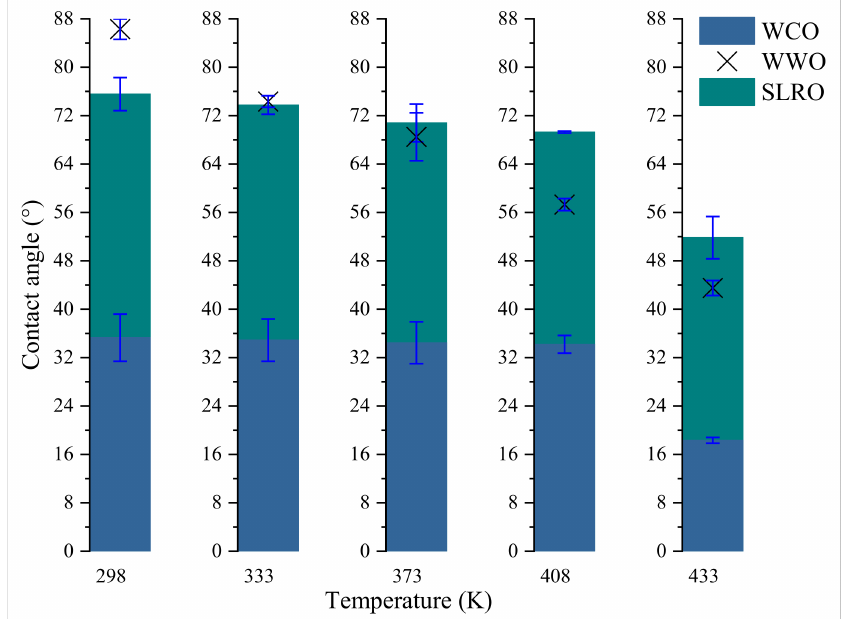
Figure 3. Bio-oils/RTFOT 360 min surfaces contact angles at different